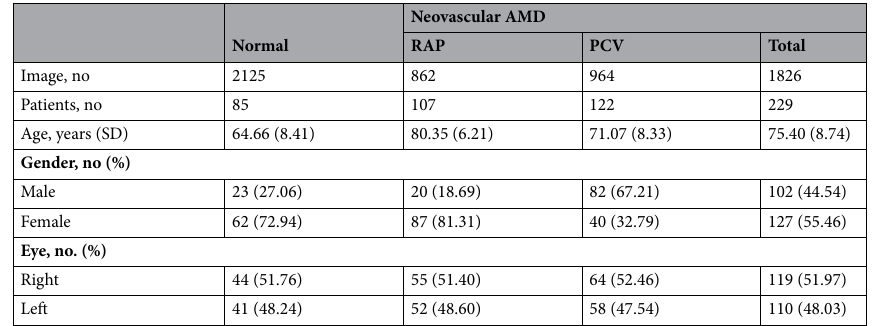
Table 1. Baseline characteristics of patients who had undergone macular OCT. OCT, optical coherence tomography; neovascular AMD, neovascular age-related macular degeneration; RAP, retinal angiomatous proliferation; PCV, polypoidal choroidal vasculopathy; SD, standard deviation.